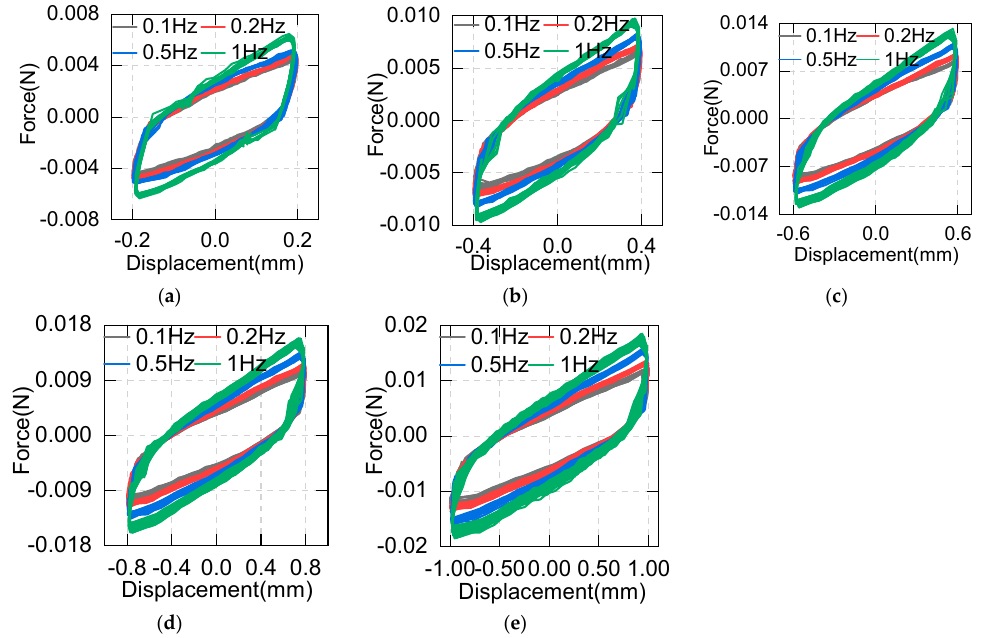
Figure 4. Hysteretic curves of the asphalt specimen under different loading frequencies at 20 °C: ( a ) maximum displacement of 0.2 mm (maximum strain of 1%); ( b ) maximum displacement of 0.4 mm (maximum strain of 2%); ( c ) maximum displacement of 0.6 mm (maximum strain of 3%); ( d ) maximum displacement of 0.8 mm (maximum strain of 4%); ( e ) maximum displacement of 1 mm (maximum strain of 5%).